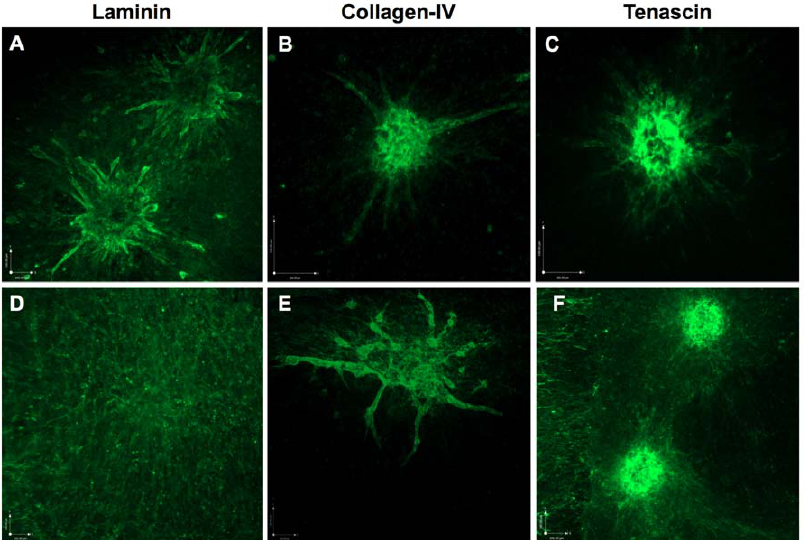
Figure 3. Immunostaining of Minitumour spheroids show deposition of extracellular matrix components. A – Minitumour spheroids incubated in collagen-I were immunostained with an anti-pan-laminin antibody and imaged by confocal microscopy showing the deposition of laminin around the endothelial sprouts after 40 h and D – a more widespread distribution after 7 days. B – Confocal microscopy of Minitumour spheroids immunostained with an anti-collagen IV antibody after 48 h shows a similar pattern, E – but after 7 days collagen-IV still localized around the endothelial cell sprouts. C – Confocal microscopy of Minitumour spheroids immunostained with an anti-Tenascin antibody show widespread distribution after 40 h, and F – after 7 days. All images were obtained using a 10 6 objective. Scale bars represent 100 m m.